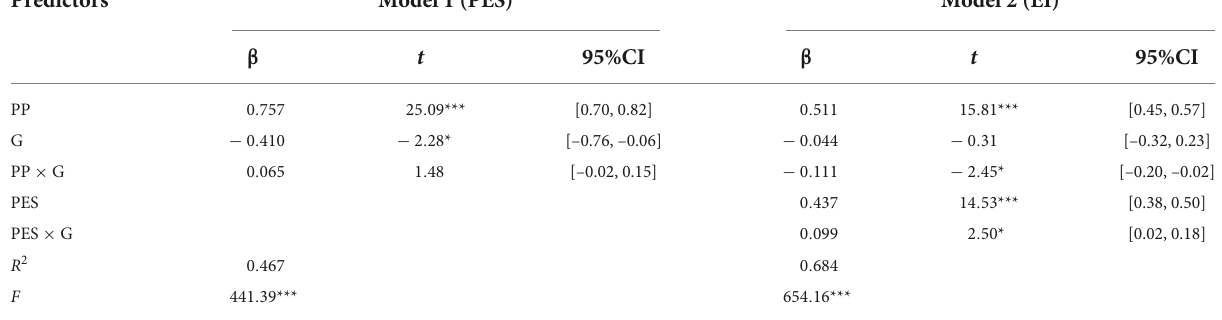
TABLE 4 The moderated mediation effect